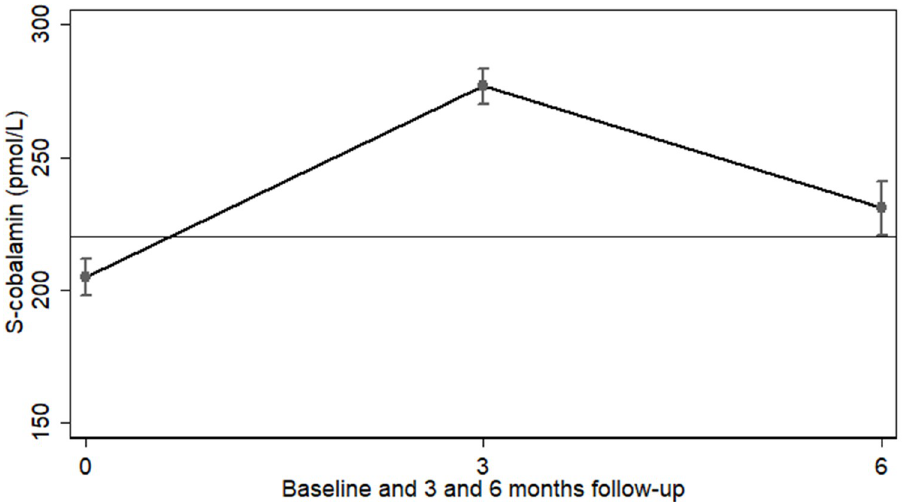
Fig 2. SC during and after supplementation. Mean (95% CI) SC at baseline ( n = 1,192), after 3 months supplementation ( n = 1,330), and after an additional 3 months without supplementation ( n = 398). Based on mixed- effects tobit regression and adjusted for age, sex, months of admission, site and baseline values of MUAC, WLZ, and LAZ, serum CRP, inflammation and morbidity, and baseline SC. Horizontal line at 222 pmol/L indicates cutoff to define normal SC. CRP, C-reactive protein; LAZ, length-for-age z-score; MUAC, mid-upper arm circumference; SC, serum cobalamin; WLZ, weight-for-length